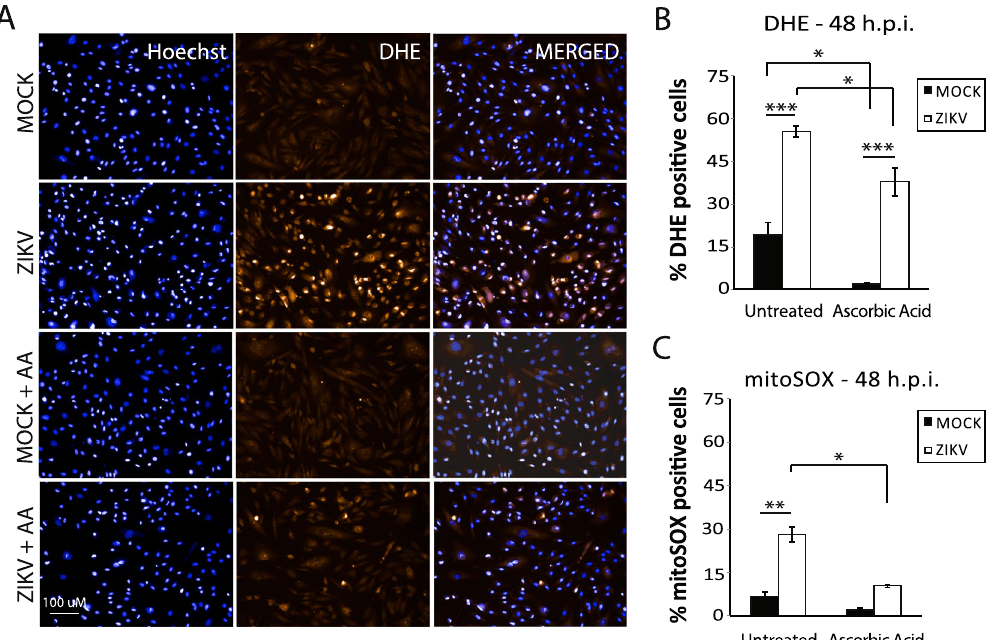
Figure 3. ROS production in ZIKV infection. ( A ) Staining of ROS superoxide indicator dye DHE in MOCK and ZIKV-infected astrocytes (untreated and treated with ascorbic acid 80 µ M). Hoechst was used for nuclei staining. N = 3. Scale bar: 100 µ m. ( B ) Quantification of DHE staining (shown as the percentage of DHE- positive cells) in MOCK and ZIKV-infected astrocytes treated or untreated with ascorbic acid. N = 3. ( C ) Quantification of mitoSOX ROS superoxide indicator dye staining (shown as the percentage of mitoSOX- positive cells) in MOCK and ZIKV-infected astrocytes untreated or treated with ascorbic acid. N = 3. Data is shown as average ± SEM; * p < 0.05, ** p < 0.01, *** p < 0.001. Astrocytes derived from iPSC lines GM23279A, CF1 and C15 were